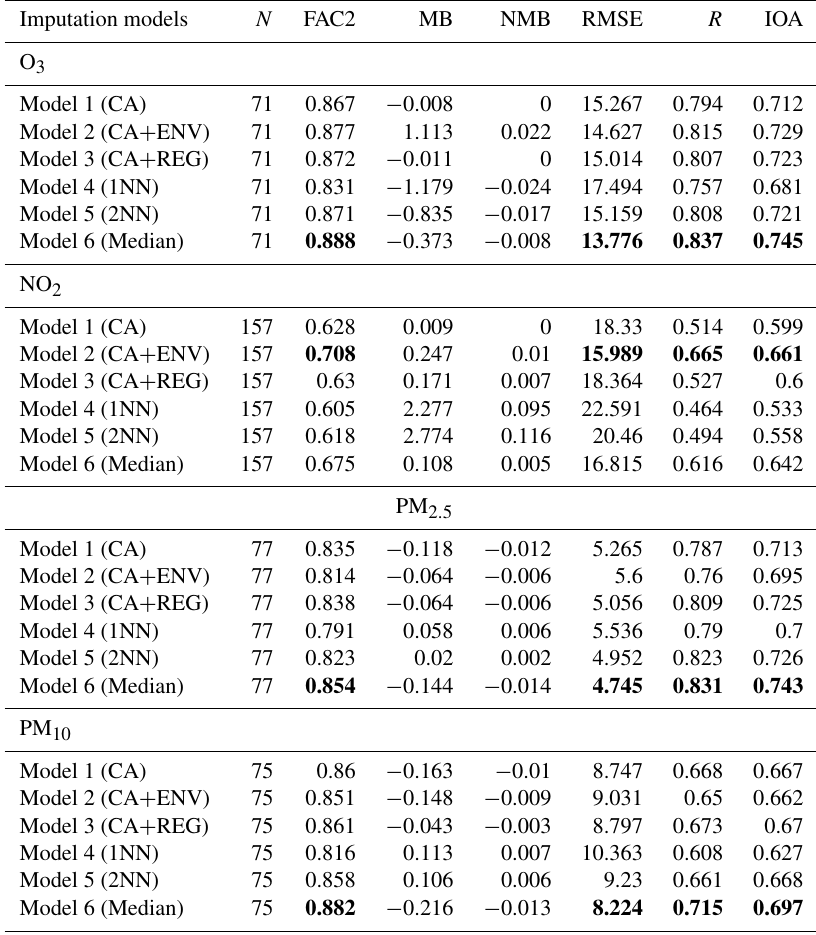
Table 1. Performance of the hourly pollutant concentration imputation models based on statistical measures. Best values are in bold for FAC2, RMSE, R , and